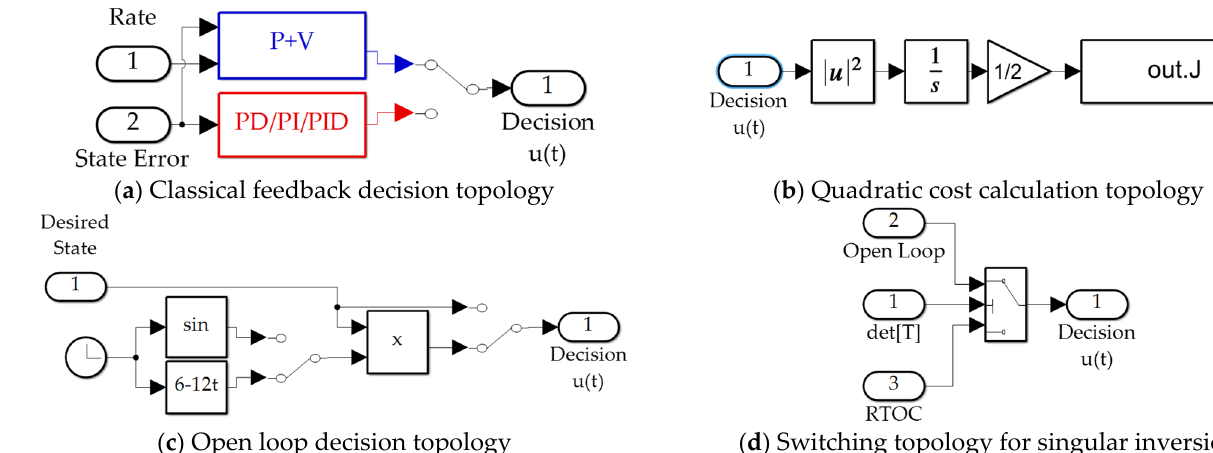
Figure 4. SIMULINK subsystems: ( a ) implementation of classical feedback methods; ( b ) calculation of quadratic cost; ( c ) open loop decision topologies (sinusoidal and optimal); ( d ) switching function to disengage use of real-time parameter updates when the matrix in Equation (39) is rank deficient. Notice in subfigure ( c ) sinusoidal wave input is coded using the identical time-index of the rest of the simulation. The next stages of future research will utilize this identical simulation to investigate efficacy of the proposed virtual sensoring amidst unknown wave actions.